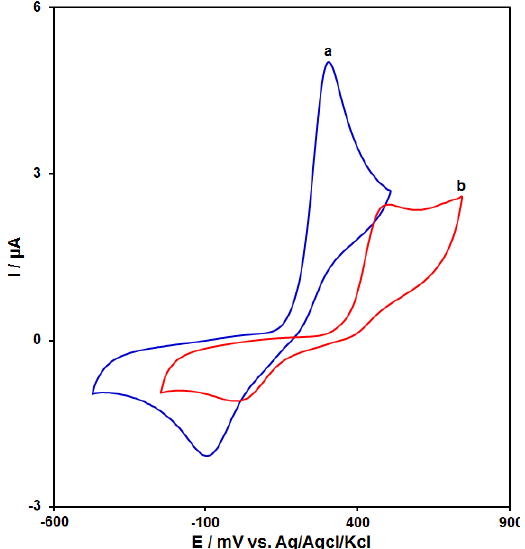
Fig. 5. Cyclic voltammograms of Cu/SPE in 0.1 M PBS (pH 7.0) Fig. 4. Cyclic voltammograms of (a) Cu/SPE and (b) bare containing 100.0 μM paracetamol at various scan rates; numbers SPE in 0.1 M PBS (pH 7.0) in the presence of 1000.0 μM 1-20 correspond to 5, 10, 20, 30, 40, 50, 60, 70, 80, 90, 100, 200, aracetamol at the scan rate 50 mVs -1 300, 400, 500, 600, 700, 800, 900 and 1000 mV s -1 , respectively. Inset: variation of anodic and cathodic peak current vs. ν